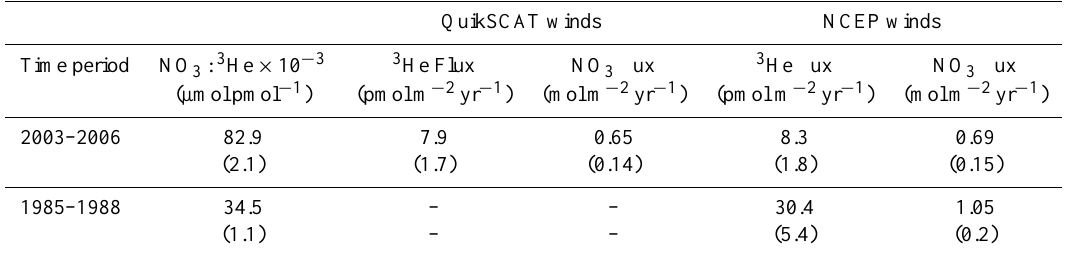
Table 1. Fluxes calculated from the flux gauge technique for two different time periods. 1 σ uncertainty estimates for each flux are given in parentheses underneath the reported value for each quantity.